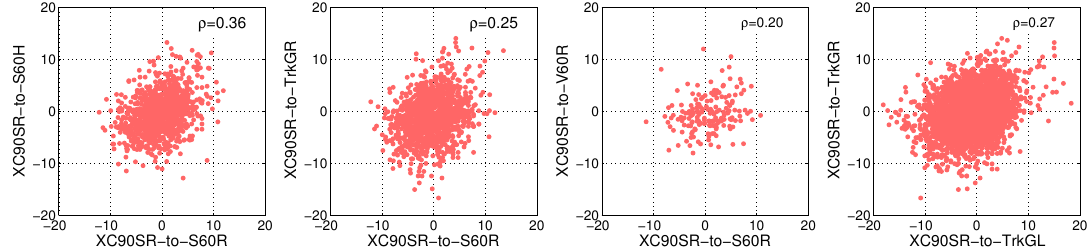
Figure 13. The multilink shadowing correlation between different links at intersection Yngve. The x-axis for the first three subfigures represents the link between the XC90 Silver Roof to the S60 Roof; the y-axis represent the communication between the XC90 Silver roof and one antenna on each vehicle in group 2. The last subfigure, show the cross-correlation of the links between the XC90 Silver Roof and the two antennas on Truck